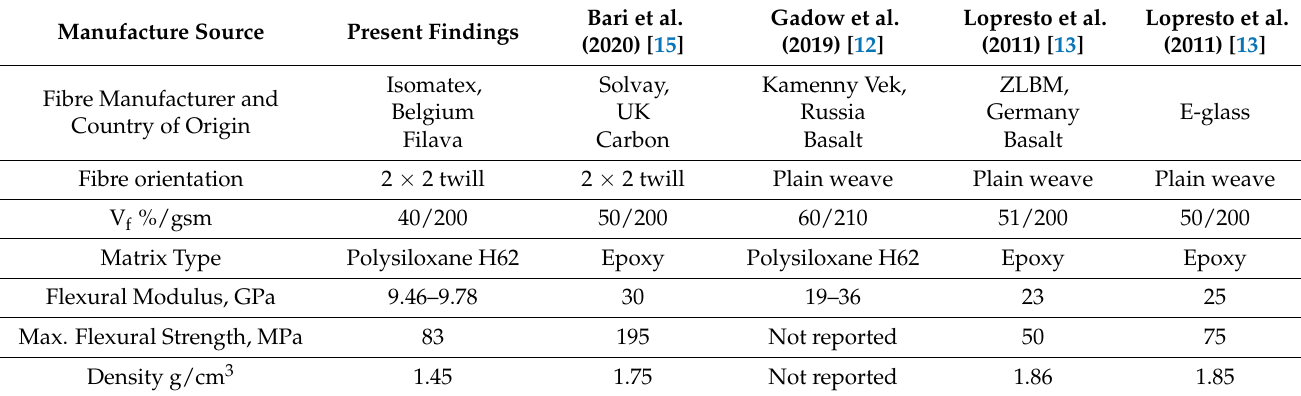
Table 5. Flexural strength of FPC with an equivalent Basalt, carbon, E-glass epoxy composite flexural according to BS ISO 14125. Manufacture